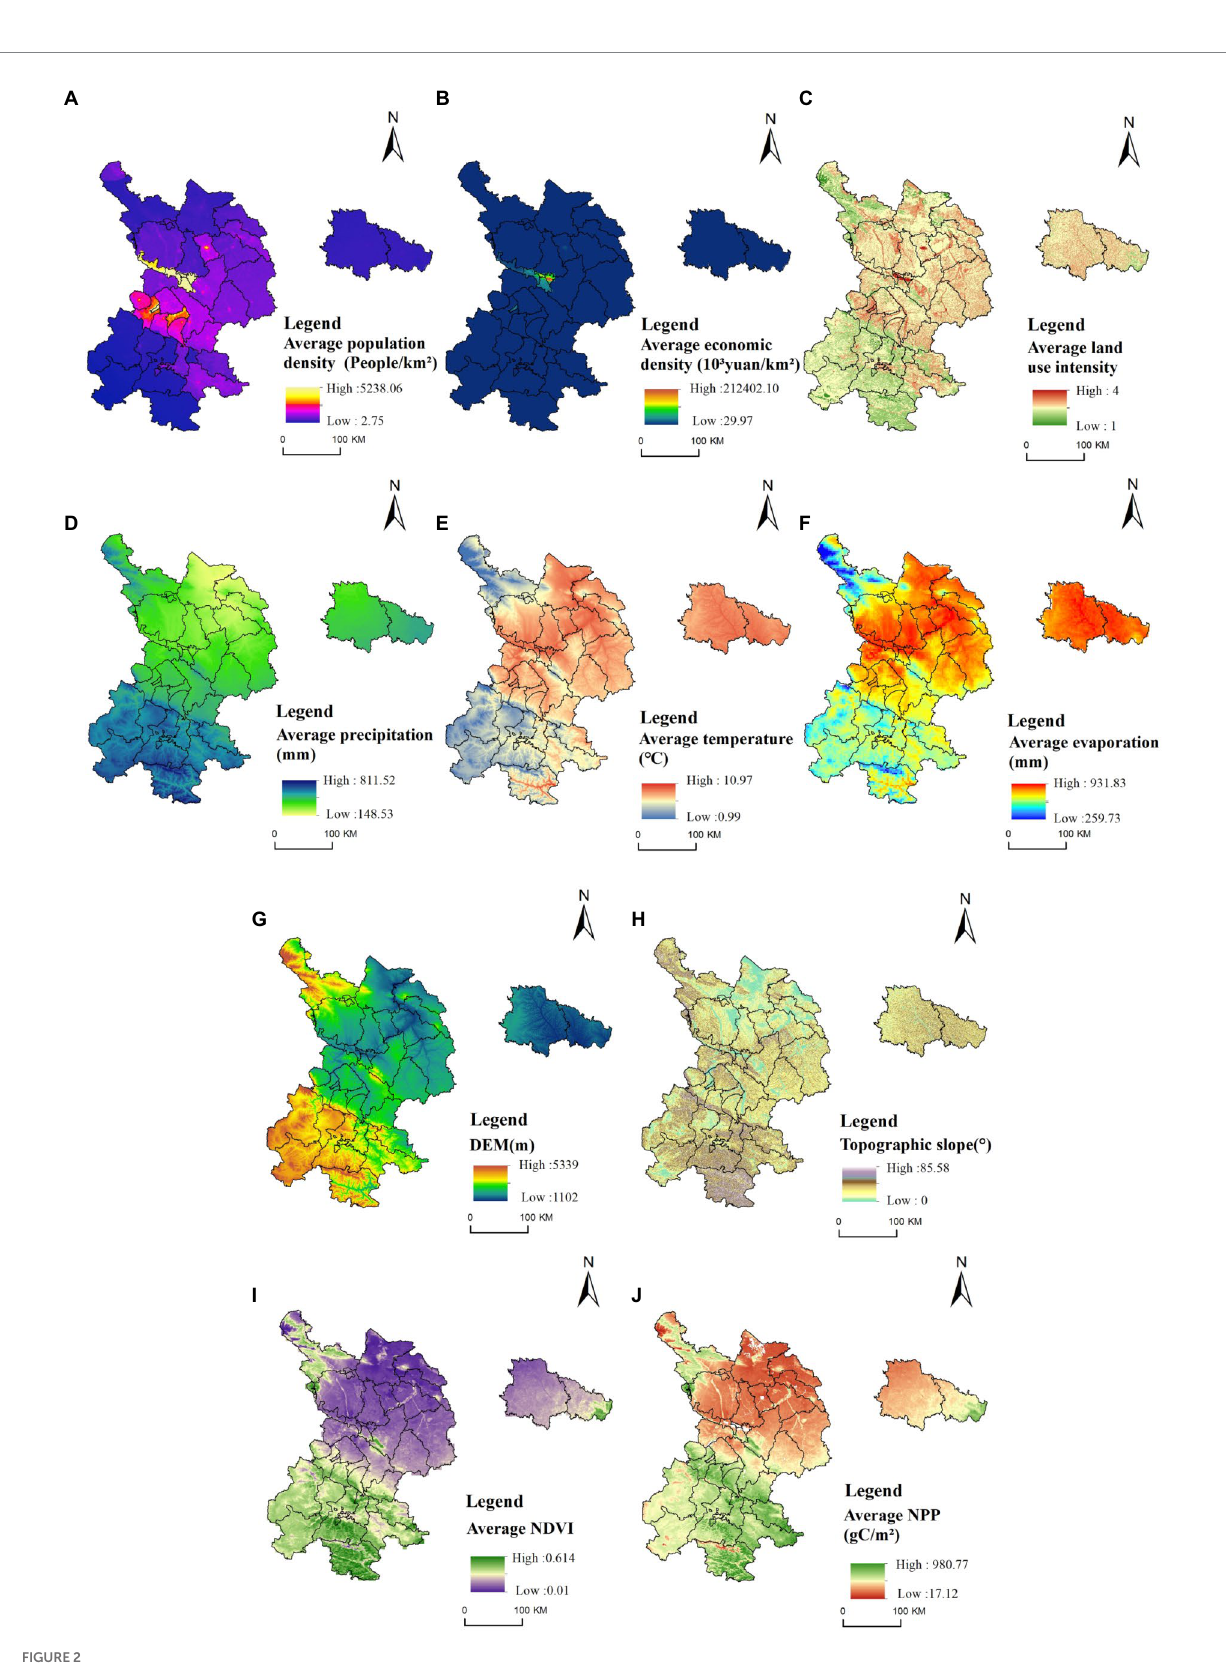
FIGURE 2 The impact factors database is briefly displayed. Due to the large amount of data, except DEM and slope data, which are basically fixed, other data are displayed spatially based on the average value from 2000 to 2020. The population density (A) and economic density (B) to some extent indicate the intensity of human activities in the region, and the intensity of land use directly (C) reflects the transformation of the natural environment by human beings. (D–F) belongs to climate data, which are average precipitation, average temperature and average evaporation respectively. (G, H) are geographic data, where are DEM and topographic slope respectively. (I, J) are ecological data, which are average NDVI and average NPP